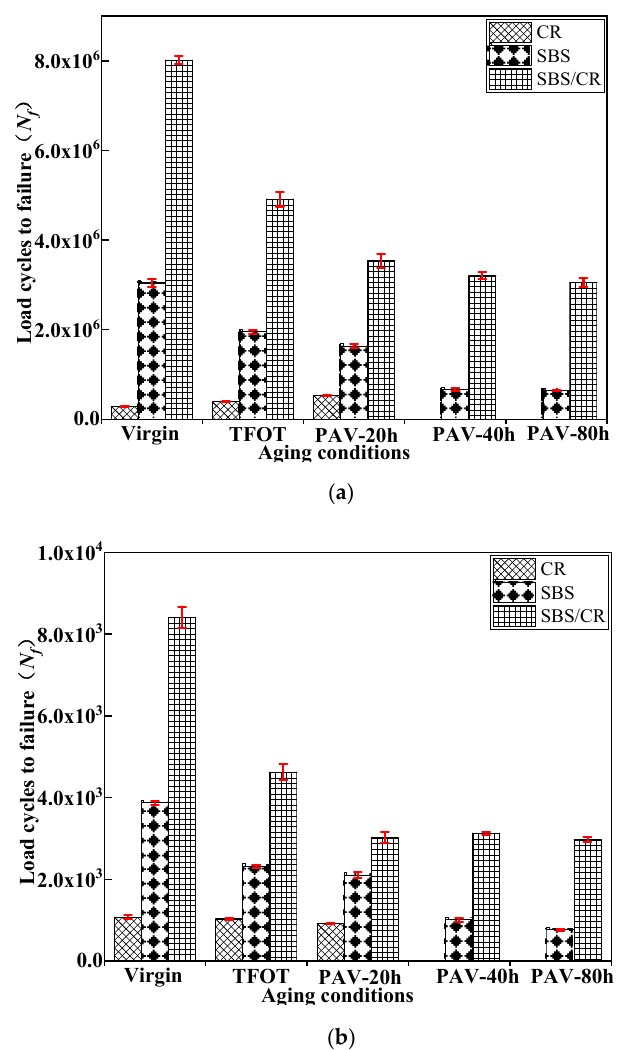
Figure 6. E ff ect of aging on LAS test fatigue life of CRMB, SBSMB and SBS / CRMB at di ff erent strain Figure 6. Effect of aging on LAS test fatigue life of CRMB, SBSMB and SBS/CRMB at different strain levels, ( a ) 1% strain level; ( b ) 10% strain levels, ( a ) 1% strain level; ( b ) 10% strain level.